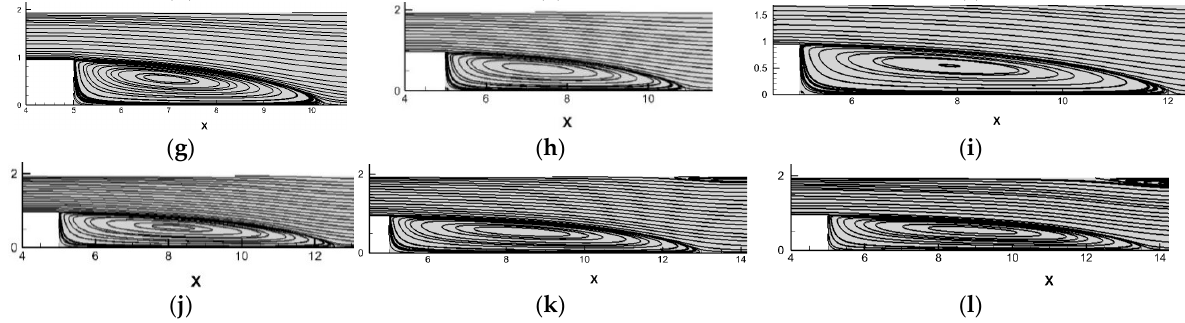
Figure 3. Streamlines near the backward facing step for flow of water at various Reynolds number: ( a ) 0.1, ( b ) 1, ( c ) 10, ( d ) 50, ( e ) 100, ( f ) 200, ( g ) 250, ( h ) 300, ( i ) 400, ( j ) 450, ( k ) 500, and ( l ) 600.